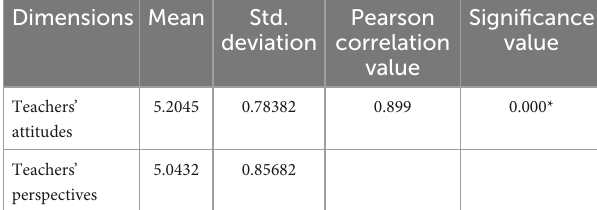
TABLE 15 Results of Pearson correlation